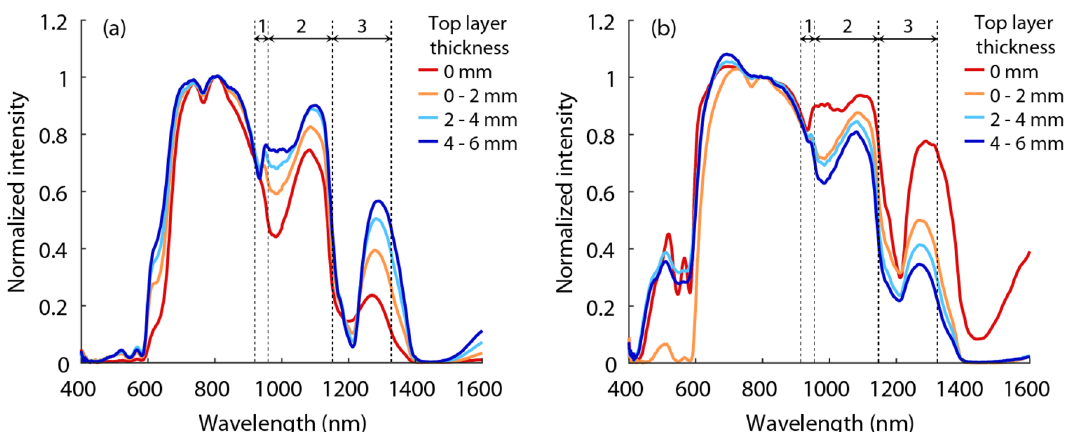
Figure 7. Mean diffuse reflectance spectra corresponding to different top layer thicknesses of fat on top of muscle tissue ( a ) and muscle on top of fat tissue ( b ), for a fiber distance of 6 mm. In the peak-based feature extraction method, the peak height was determined for the three outlined regions.